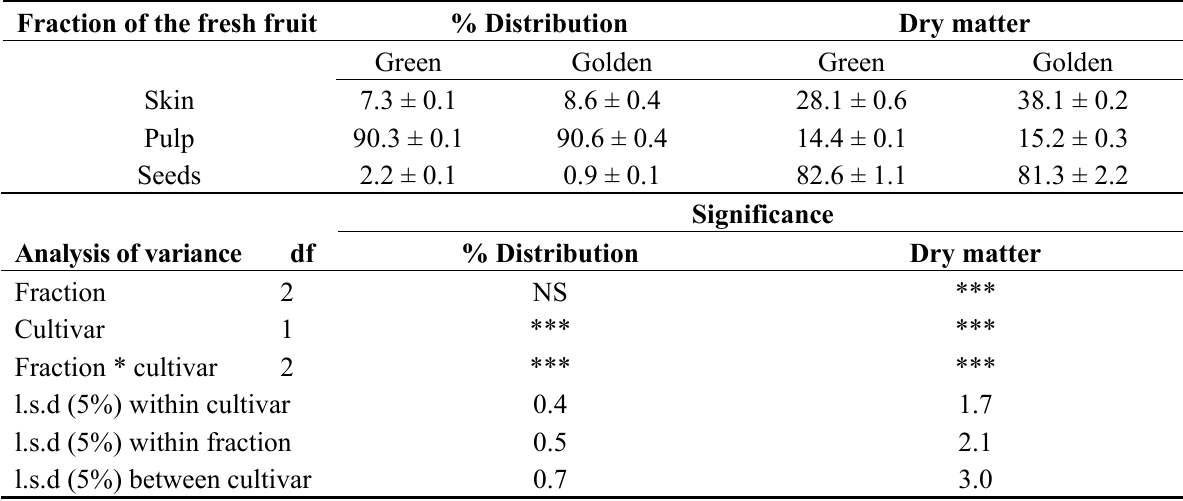
Table 1. The % distribution and dry matter (g/100 g FW) of the three fractions of ripe, ready to eat green and gold kiwifruit ( n = 3).